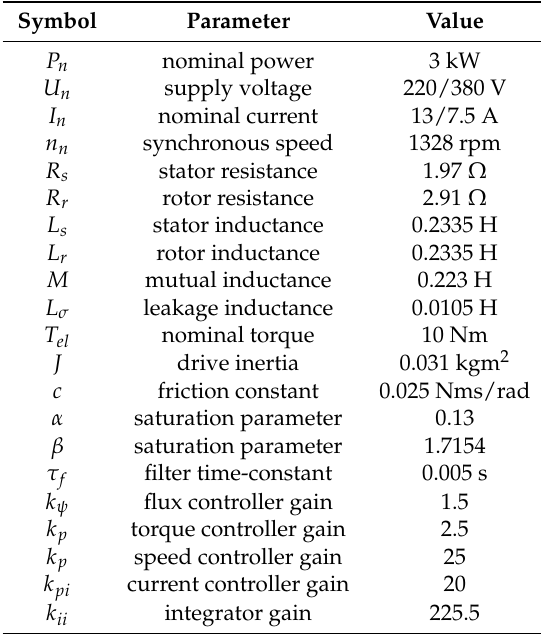
Figure 2. ( a ) Reference torque; ( b ) optimal flux magnitude; ( c ) optimal currents. Table 1. Nominal motor data and controller